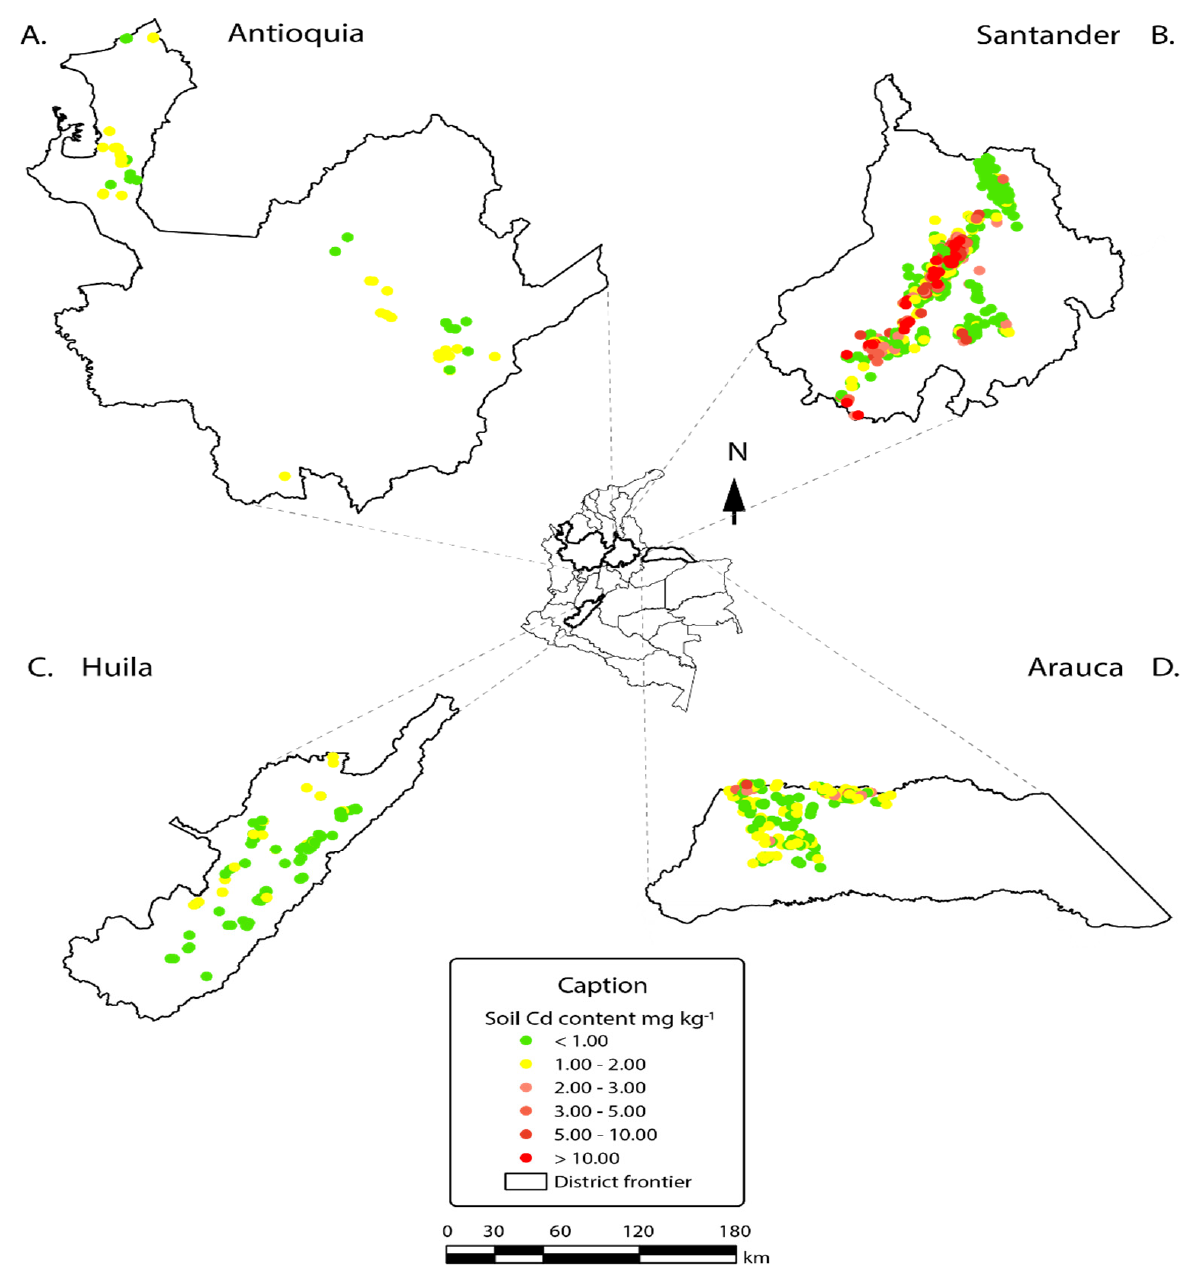
Figure 4. The relationship between cadmium content (Cd) in the soil and the number of farms assessed in four out of nineteen districts selected for comparison. It is highlighted the bigger number of samples in Santander, regarding other districts. ( A ). Antioquia district, ( B ). Santander district, ( C ). Huila district, ( D ). Arauca district.